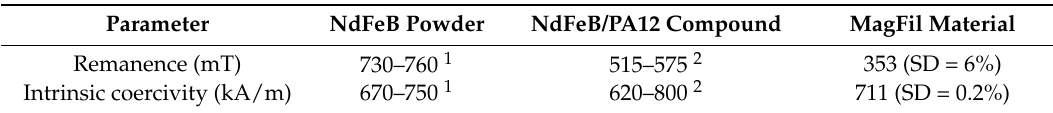
Magnetic properties of the NdFeB powder, the NdFeB/PA12 compound, and the MagFil